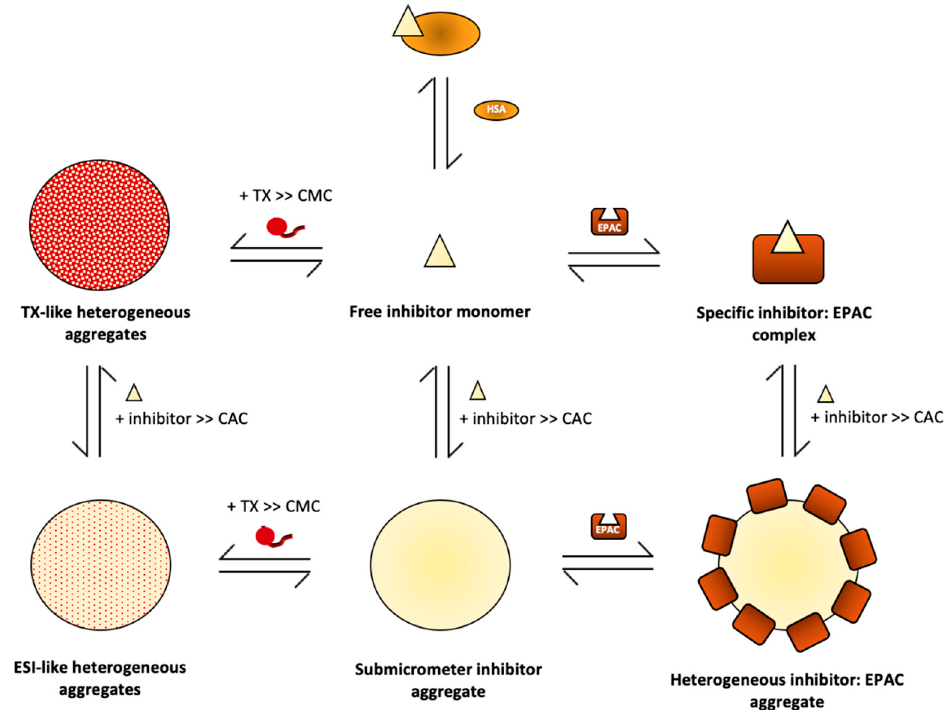
Figure 4. Specific and non-specific interactions of aggregation-prone inhibitors and aggregation attenuators in the context of EPAC. Aggregation-prone inhibition tends to decrease specific EPAC:ESI interactions. Inert type-A inhibitoraggregates do not interact withthe protein receptor, however, they act assinksforinhibitors, decreasingthefreeinhibitorconcentrationwhichultimatelyreducesacompound’s specific inhibitory e ff ect at a particular concentration. In contrast, invasive type-B inhibitor aggregates non-specifically adsorb protein molecules, directly interfering with enzyme:inhibitor interactions. To attenuate the e ff ects of ABI, TX, and HSA are commonly used. HSA directly binds monomeric inhibitors, decreasing free inhibitor concentration, which protects the system from aggregate